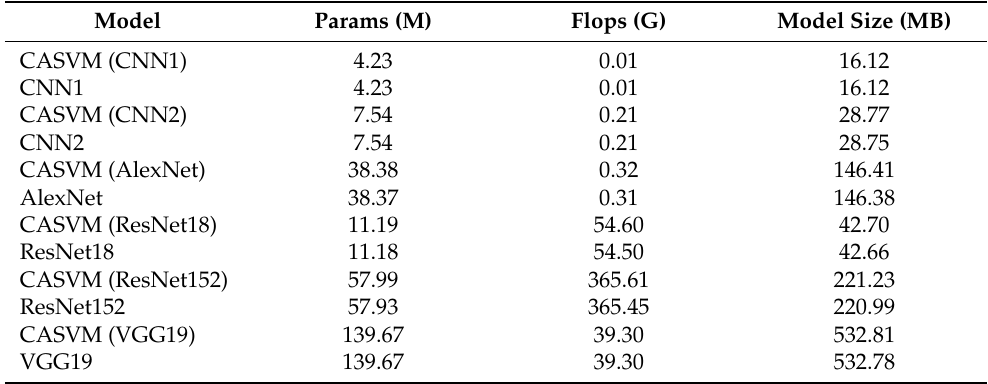
Table 2. Number of model parameters and calculation